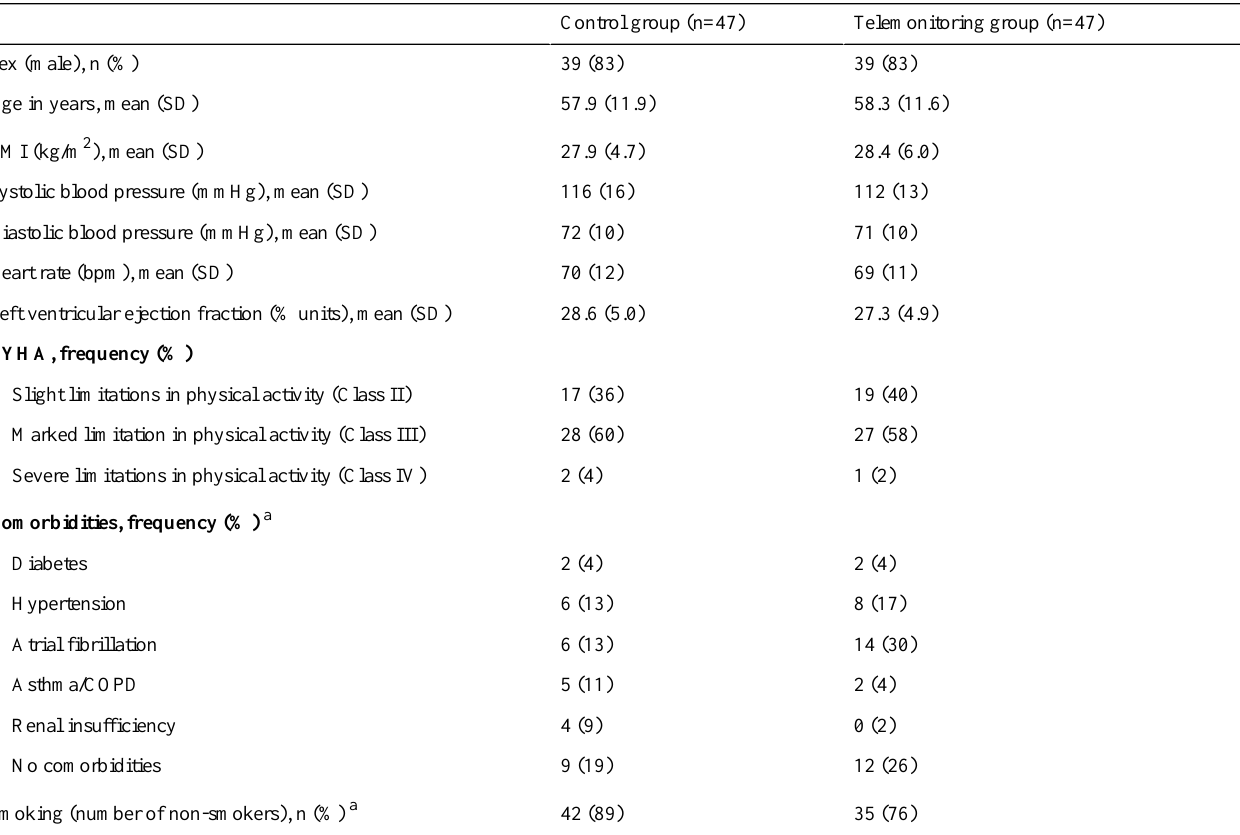
Table 1. Baseline characteristics of the patients: mean (standard deviation) or frequency